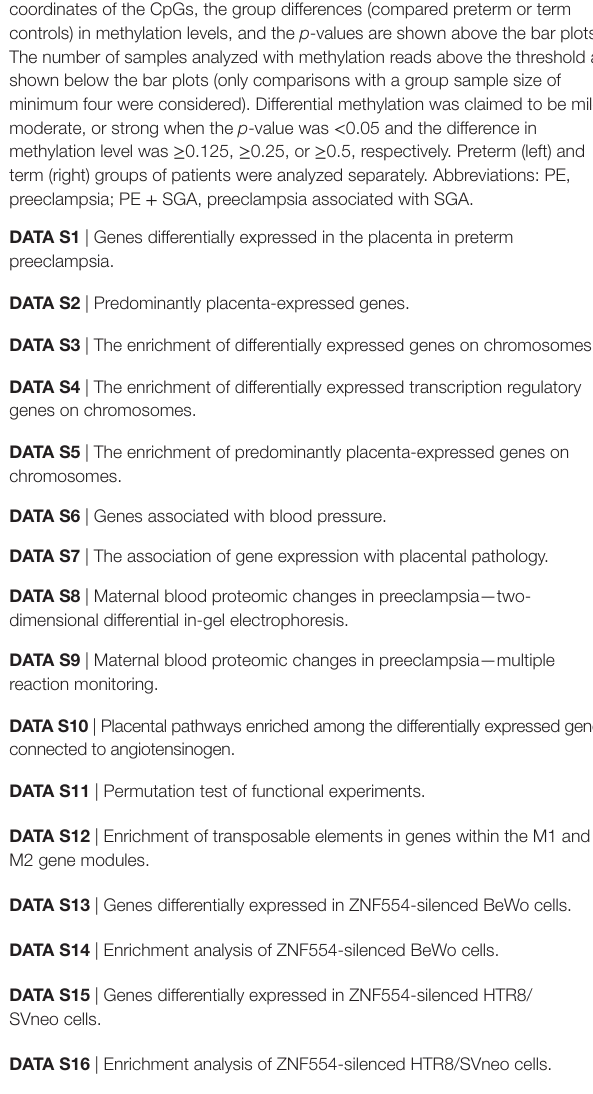
FigUre s8 | DNA methylation regulates BCL6 expression in the trophoblast. (a) Decreased BCL6 expression was observed in BeWo cells upon treatment with